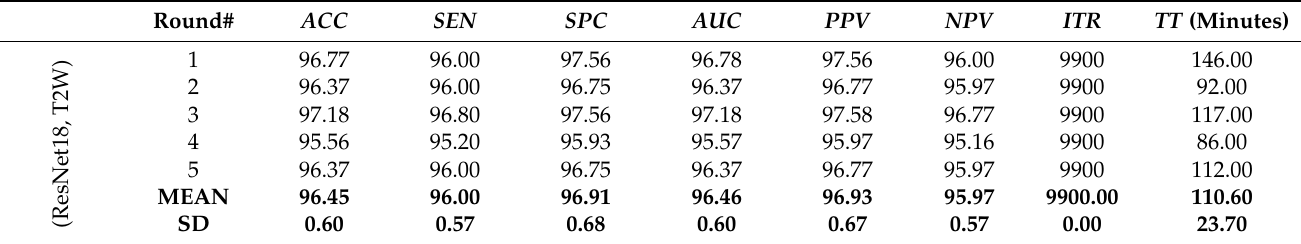
Table A11. Test results of five-folds of the experiment (ResNet18, T2W).